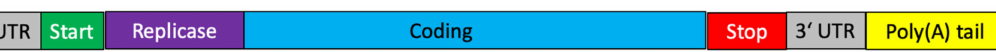
Figure 2. Structure of saRNA containing an additional replicase